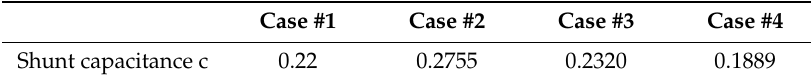
Table 6. Measured p.u.l. capacitances of the four cases in µ F / km.